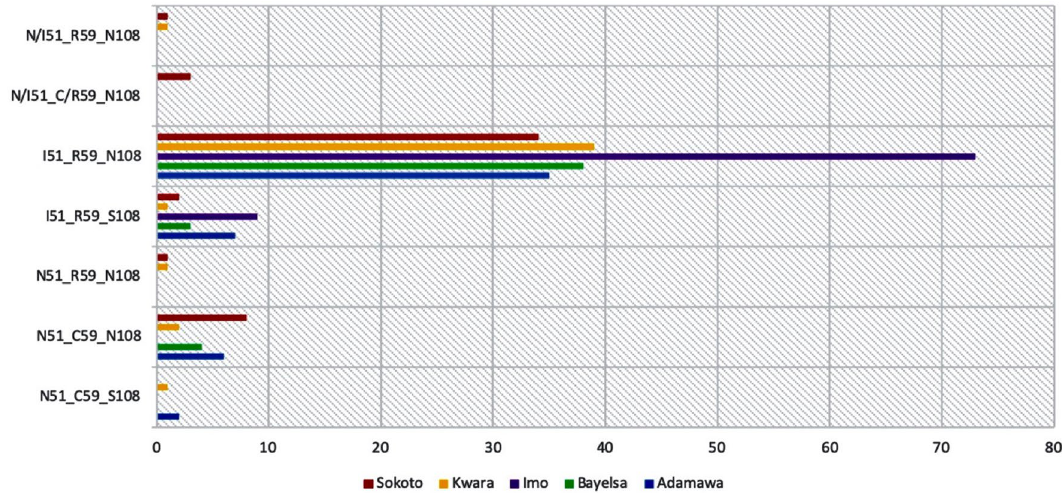
Figure 2. Bar chart showing the distribution of dhfr haplotypes in five Nigerian States. Red colour represents Sokoto State, Yellow represents Kwara State, Purple represents Imo State, Green represents Bayelsa State and Blue represents Adamawa State. The triple mutant haplotype I 51 R 59 N 108 was the most distributed in all five States.